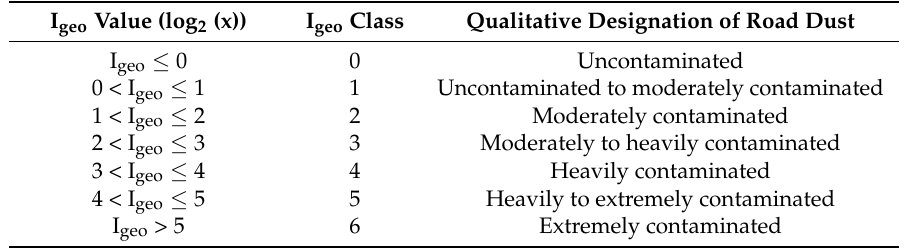
Table 1. Value, classes and qualitative description of geo-accumulation index (I geo )